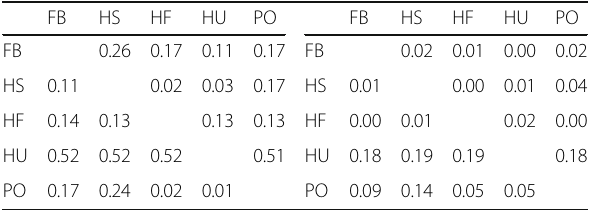
Table 2 d-mAP scores for the HOG (left) and HOGHOFMBH (right) models on ShakeFive2. In columns the true class, in rows the tested